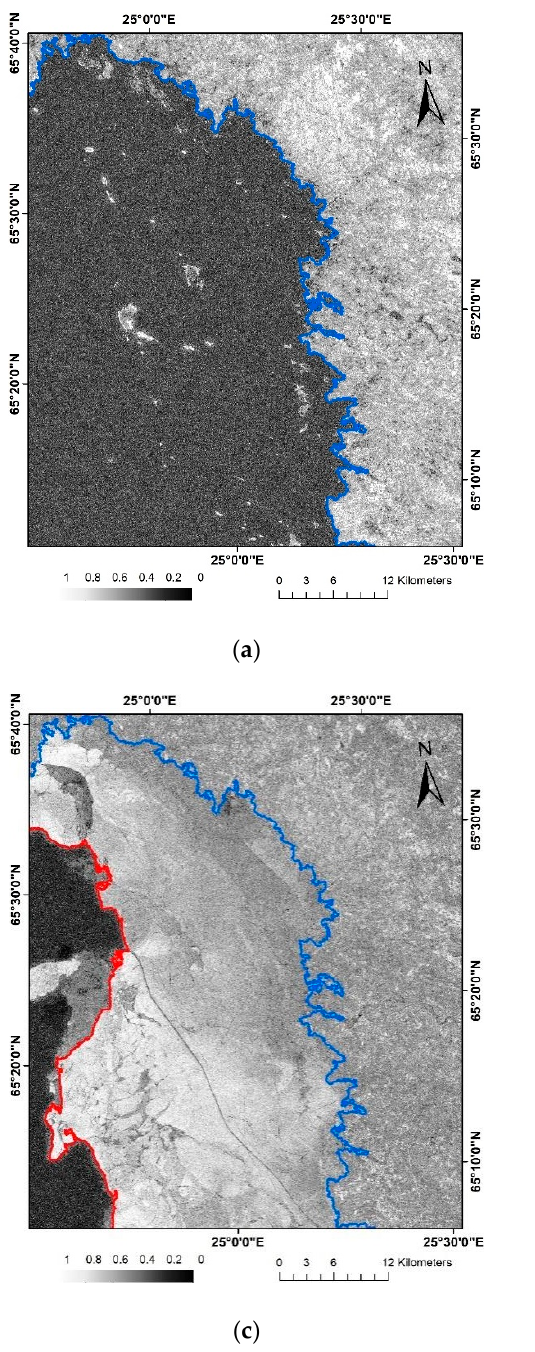
Figure 4. The extracted results by modified approach: ( a ) The land–water boundary extracted by image pair 1 (see Table 1); ( b ) The seaward edge lines of landfast ice extracted by image pair 2 (see Table 1); ( c ) The seaward edge lines of landfast ice extracted by image pair 3 (see Table 1); ( d ) The seaward edge lines of landfast ice extracted by image pair 4 (see Table 1). The blue line represents the land–water boundary and the red lines represent seaward edge lines of landfast ice.